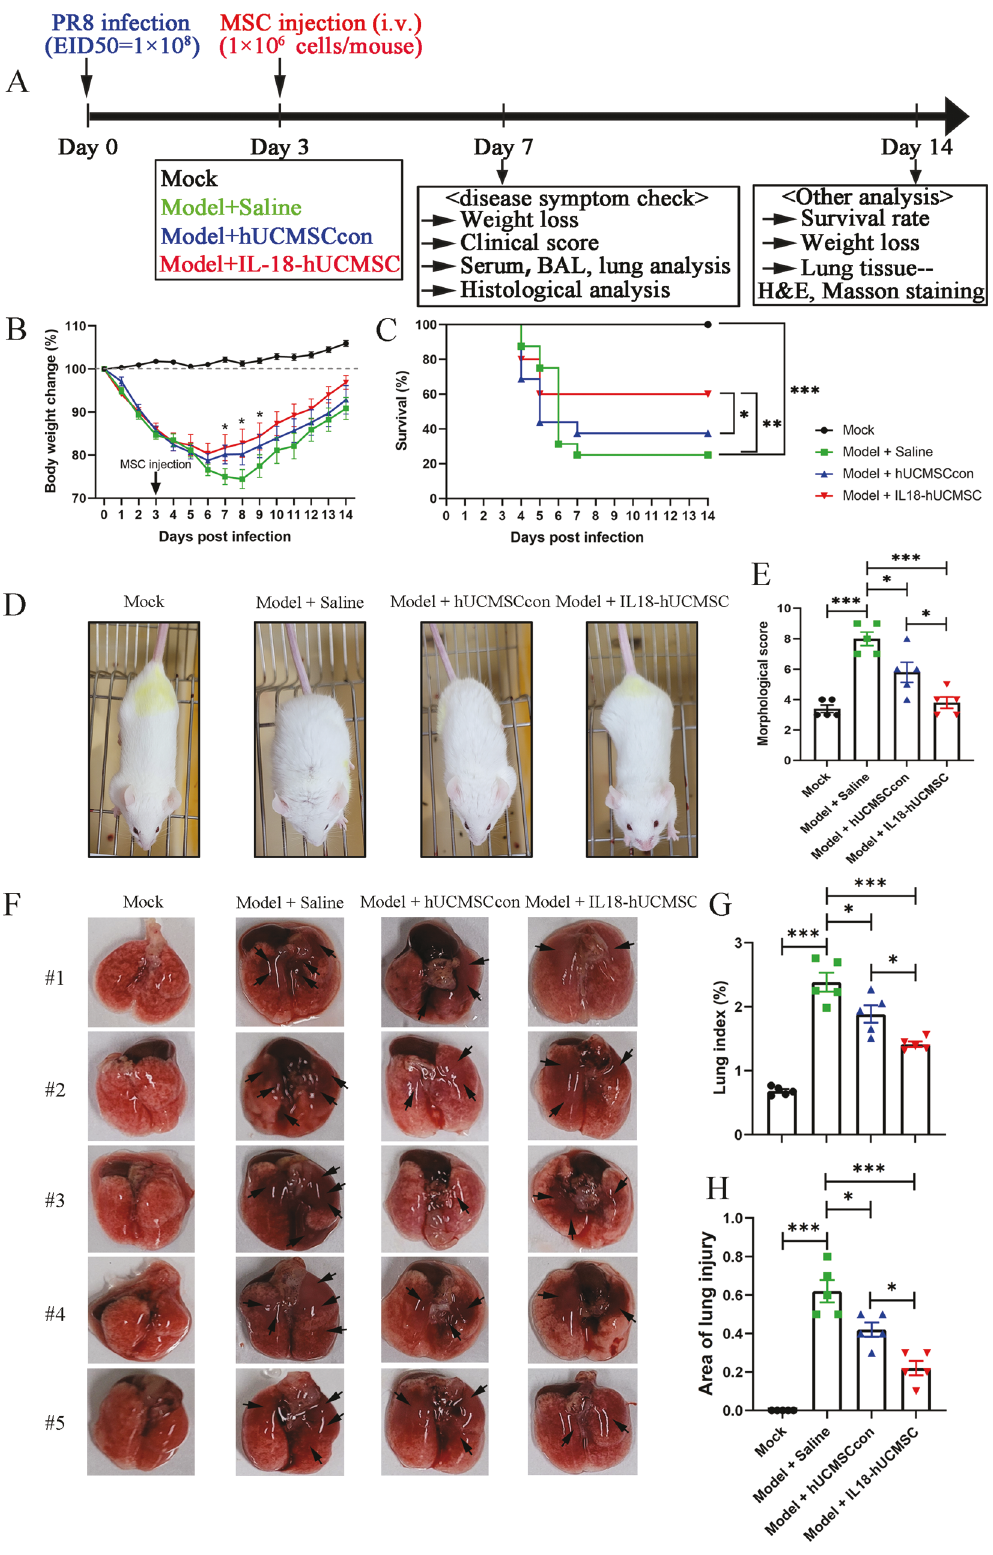
there are signi fi cant differences at 7 dpi, 8 dpi, and 9 dpi, compared with the saline treatment group (Fig. 3B). The survival rates signi fi cantly decreased in the Model + Saline group com- pared with the Mock group and Model + IL18-hUCMSC